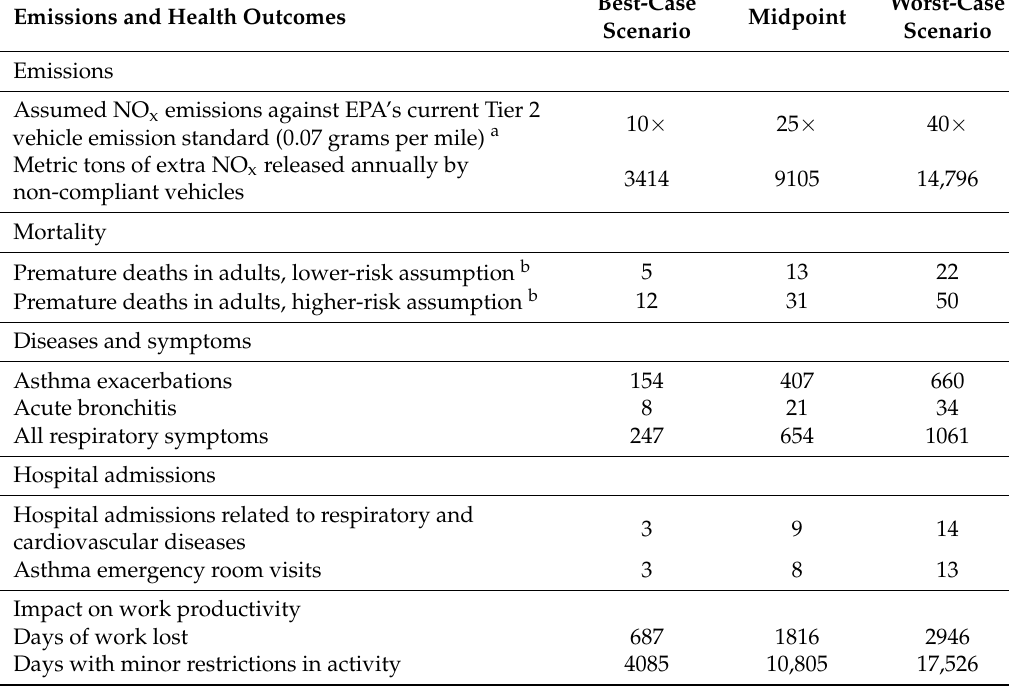
Table 1. Total emissions and estimated annual premature deaths, hospital admissions, and diseases attributable to Volkswagen vehicles’ lack of compliance with EPA standards in the U.S.